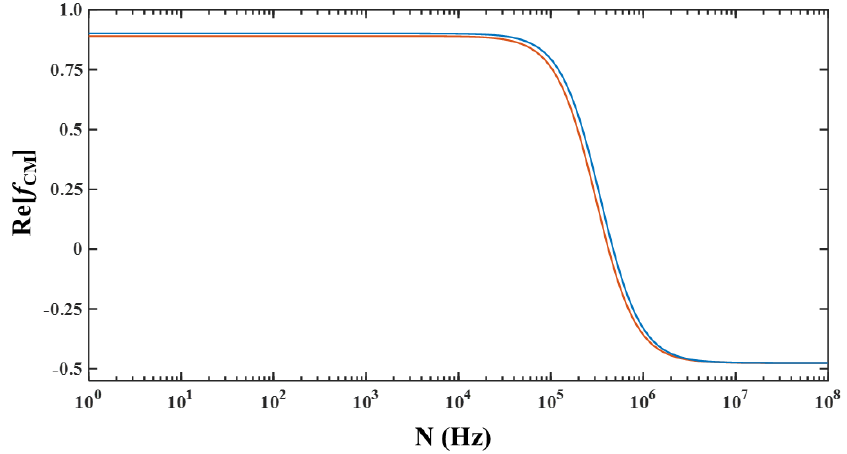
Figure 1. Variation of Re [ f CM ] with operating frequency ( N ) for 2-μm ( ■ ) and 2.25-μm ( ■ ) microparticles.